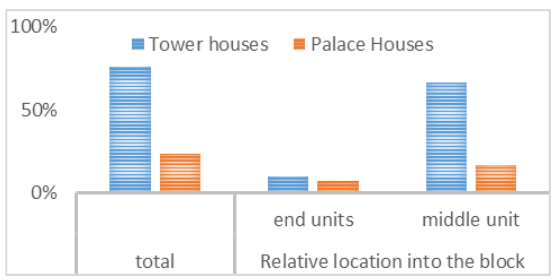
Figure 5. Analysis of morpho-typology of